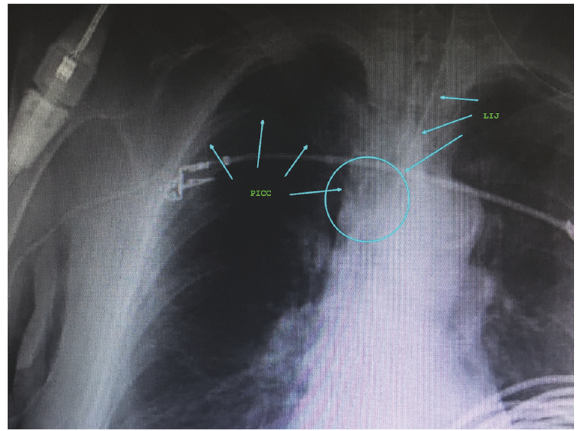
Figure 3: Chest X-ray showing multiple superficial EKG electrodes, endotracheal tube, and right upper extremity PICC line abutting LIJ venous catheter in SVC with 60-degree angle at